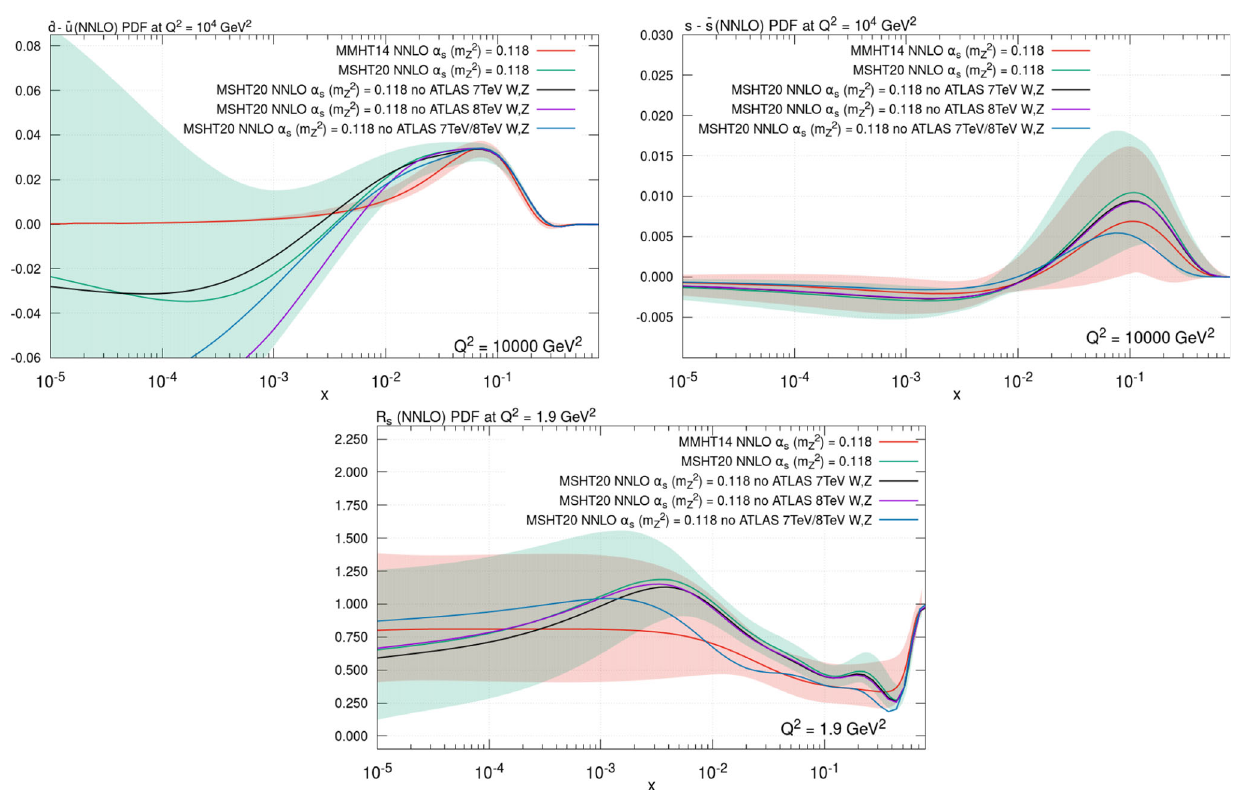
Fig. 65 (Left) ¯ d − ¯ u PDF, (right) s − ¯ s PDF and (bottom) R s at NNLO, the former two at Q 2 = 10 4 GeV 2 and the latter at Q 2 = 1 . 9 GeV 2 , all showing the effects of removing just the 7 TeV ATLAS W , Z data or the combinationoftheATLAS8TeV W ± dataandATLAS8TeV Z double